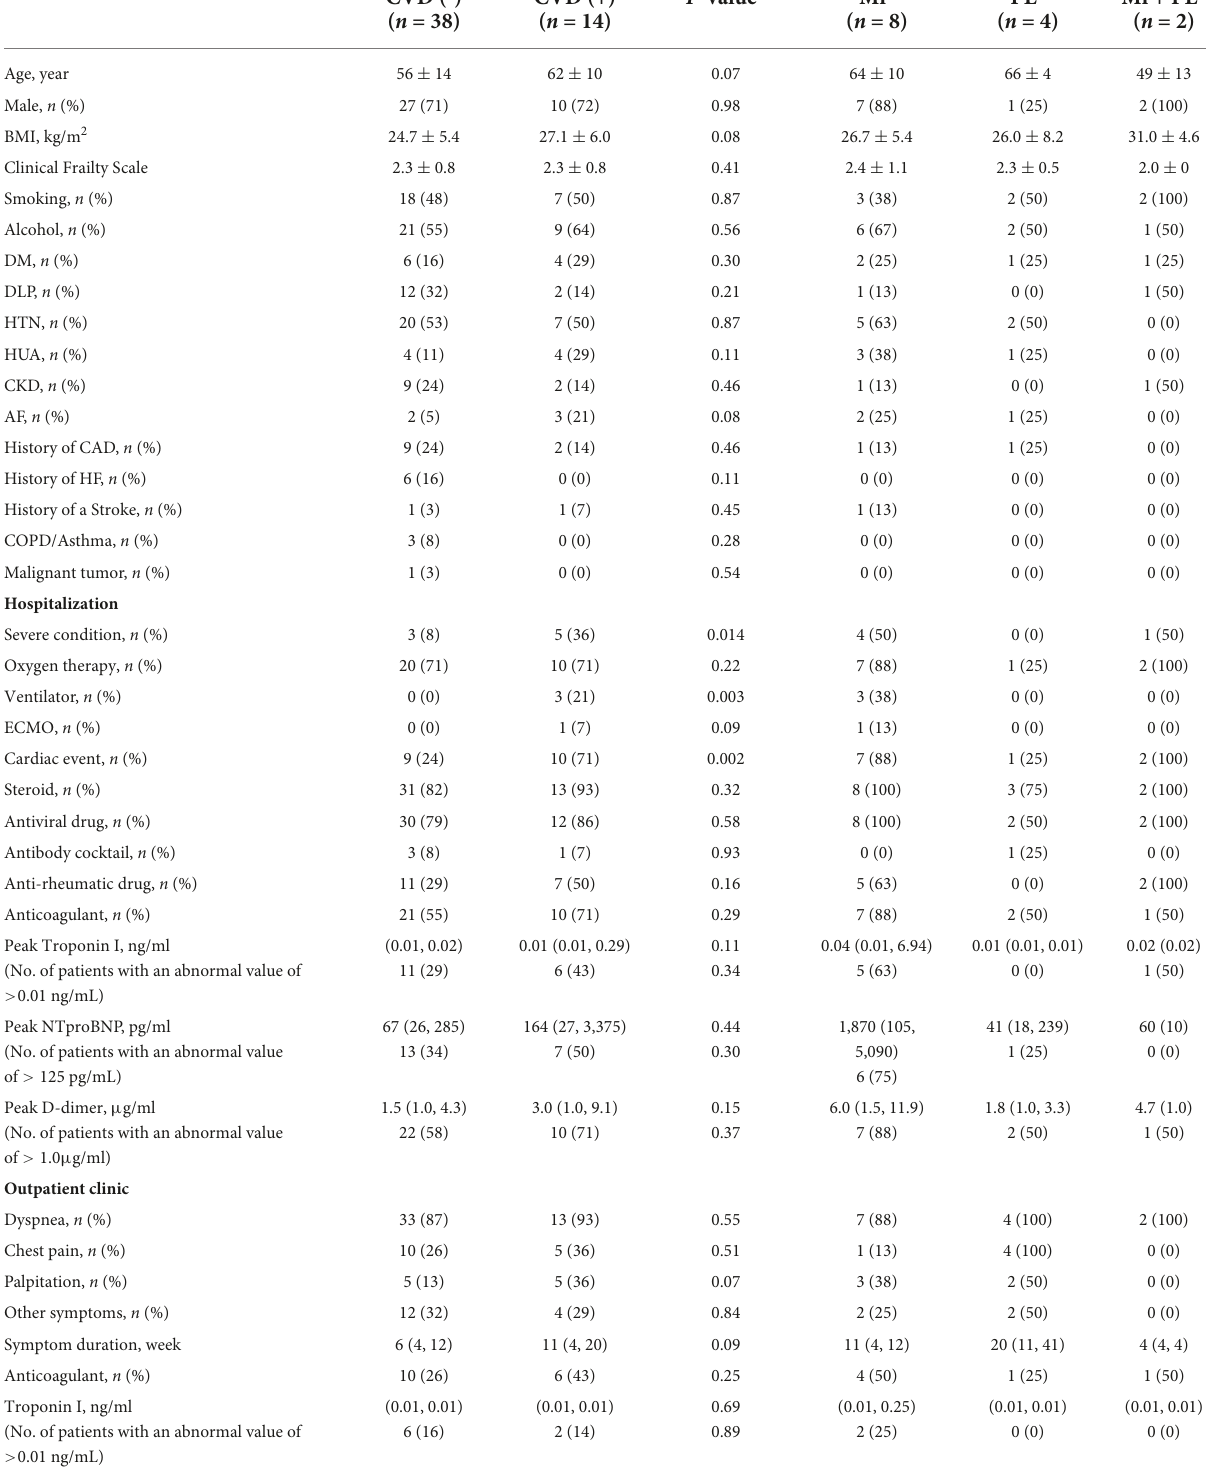
TABLE 1 Clinical characteristics of patients with and without cardiovascular